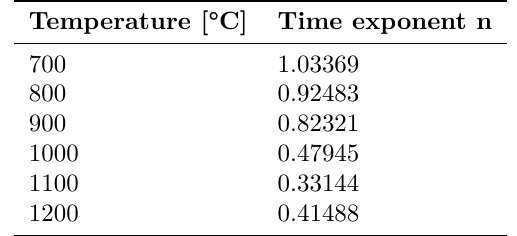
Table 2. Time exponents of the oxidation kinetics